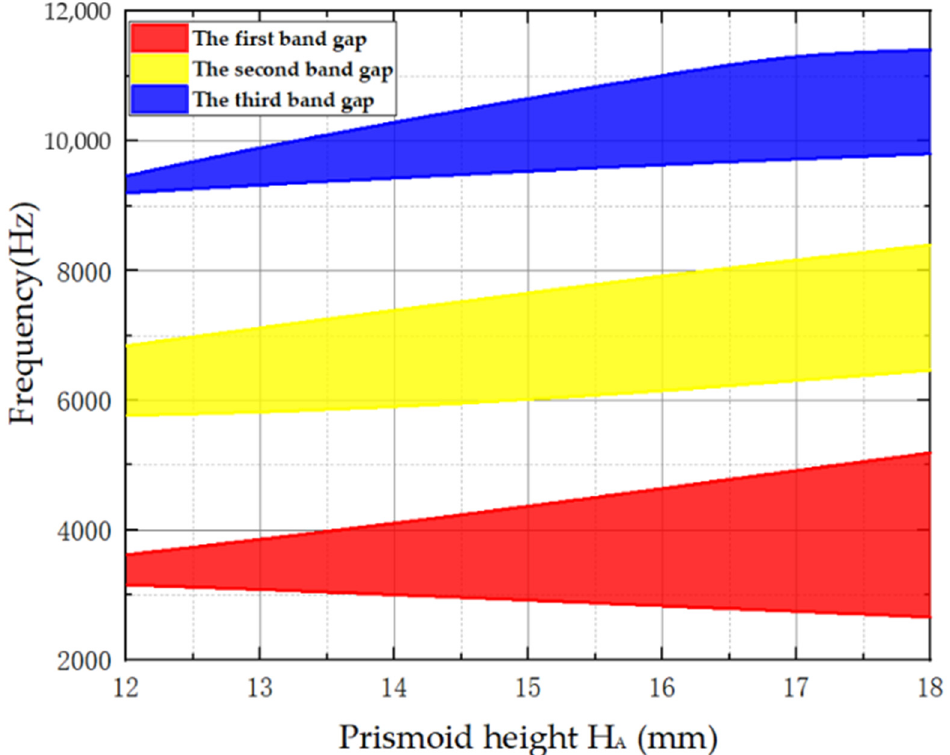
Figure 13. Influence of prismoid height on the band gaps.